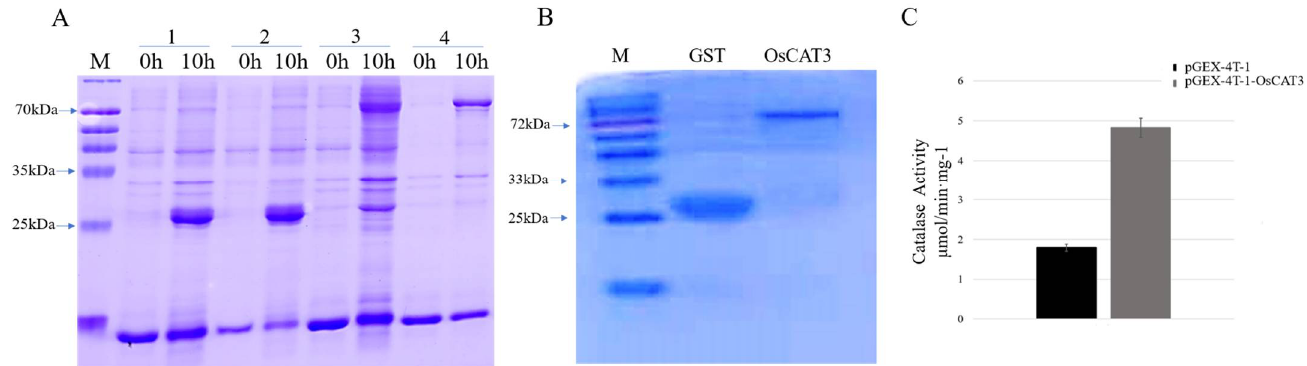
Figure 5. OsCAT3 prokaryotic expression and H 2 O 2 scavenging activity analysis. ( A ): SDS−PAGE analysis of pGEX−4T−1−OsCAT3 fusion protein in E. coli BL21 strain cells before and after IPTG induction; M. protein maker; 1. gel electrophoresis results of BL/pGEX−4T−1 total protein after 0 and 10 h of induction; 2. gel electrophoresis results of BL/pGEX−4T−1 supernatant proteins after 0 and 10 h of induction; 3. gel electrophoresis results of BL/pGEX−4T−1−OsCAT3 total protein after 0 and 10 h of induction; and 4. gel electrophoresis results of BL/pGEX−4T−1−OsCAT3 supernatant proteins after 0 and 10 h of induction. ( B ): Purification of pGEX−4T−1−OsCAT3 recombinant protein; GST. Gel electrophoresis results of BL/pGEX−4T−1 protein purification; OsCAT3. Gel electrophoresis results of BL/pGEX−4T−1−OsCAT3 protein purification. ( C ): H 2 O 2 scavenging activity analysis of the purified fusion protein pGEX−4T−1−OsCAT3 in vitro.